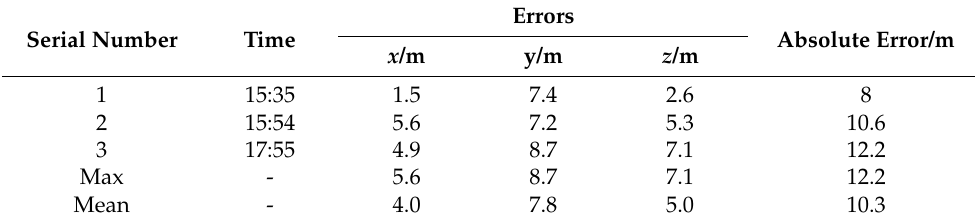
Table 5. Blasting test